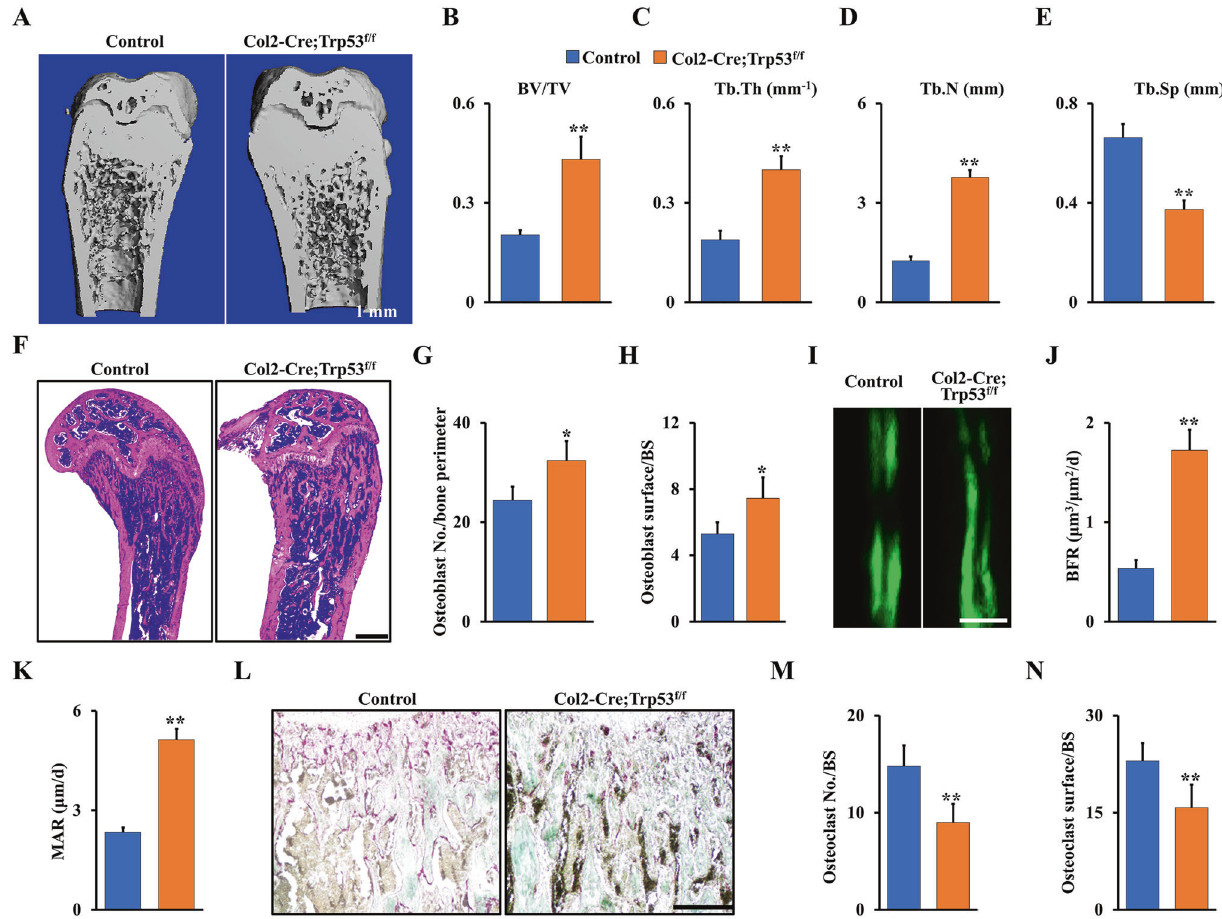
Fig. 3 Trp53 de fi ciency in chondrocytes promotes bone formation. A Representative micro-CT reconstruction as indicated at 2 months. N = 5. Scale bars, 1 mm. B – E Histomorphometric analysis of bone parameters from ( A ) as shown. F Representative H&E images of femur sections from 2-month-old Col2-Cre;Trp53 f/f mice and controls. N = 5. Scale bar, 1 mm. G Osteoblast number per bone perimeter. H Osteoblast surface per bone surface (osteoblast surface/BS). I – K Representative image of double calcein labeling in the tibia from 2-month-old Col2- Cre;Trp53 f/f mice and controls. Scale bar, 50 μ m. L TRAP staining. Scale bar, 50 μ m. M Osteoclast No./BS. N Osteoclast surface/BS. ** P <